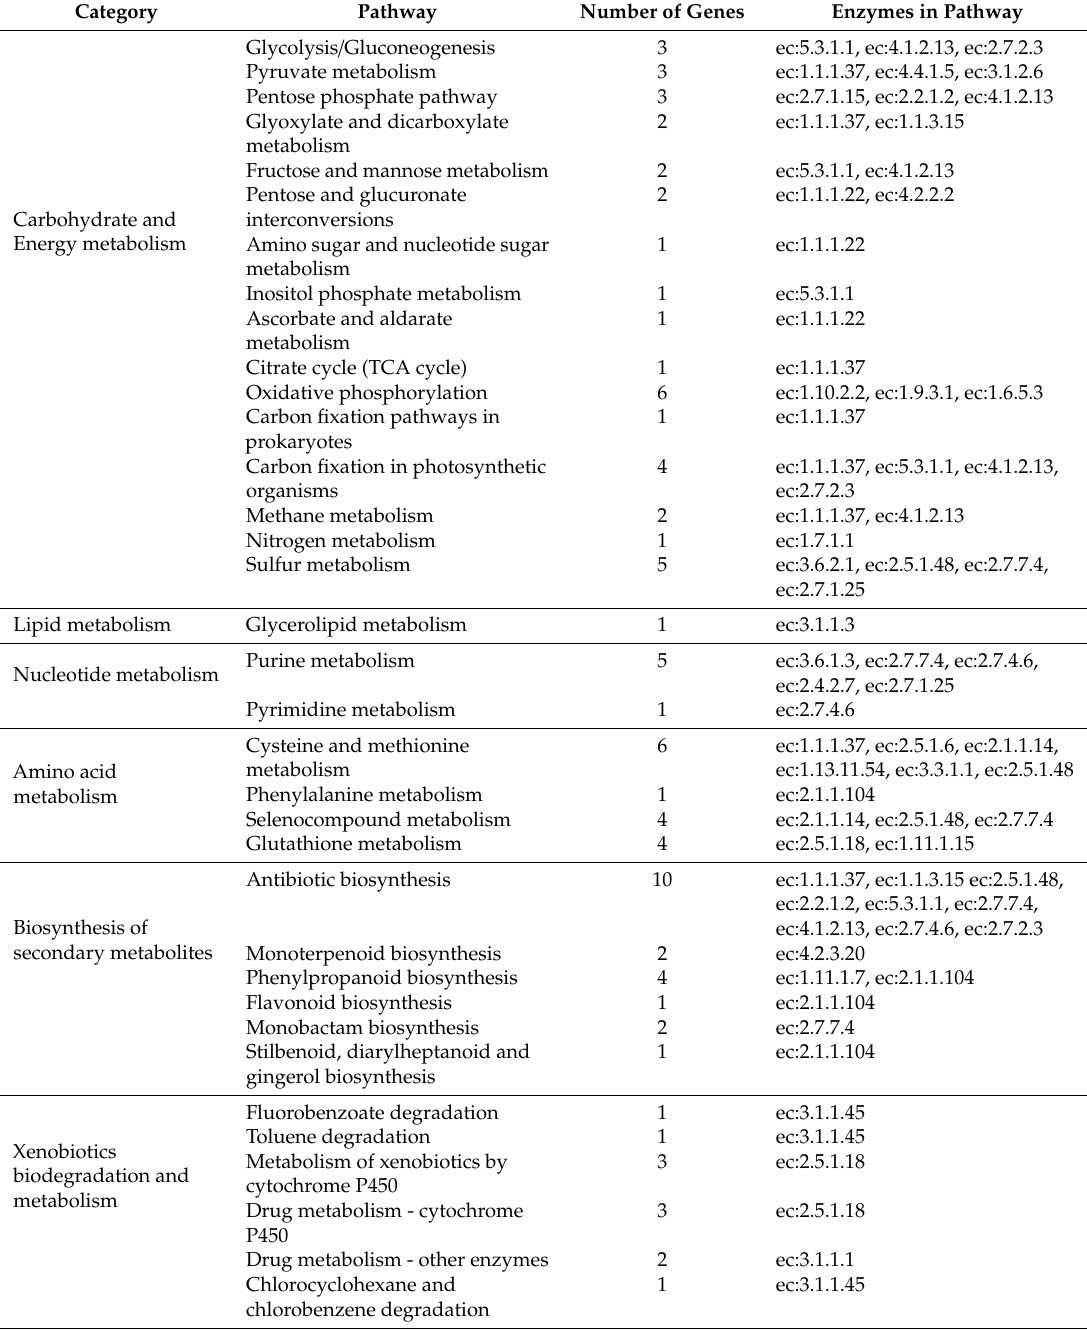
Table 2. List of KEGG pathways of orange fruits treated with PGE and their corresponding genes.